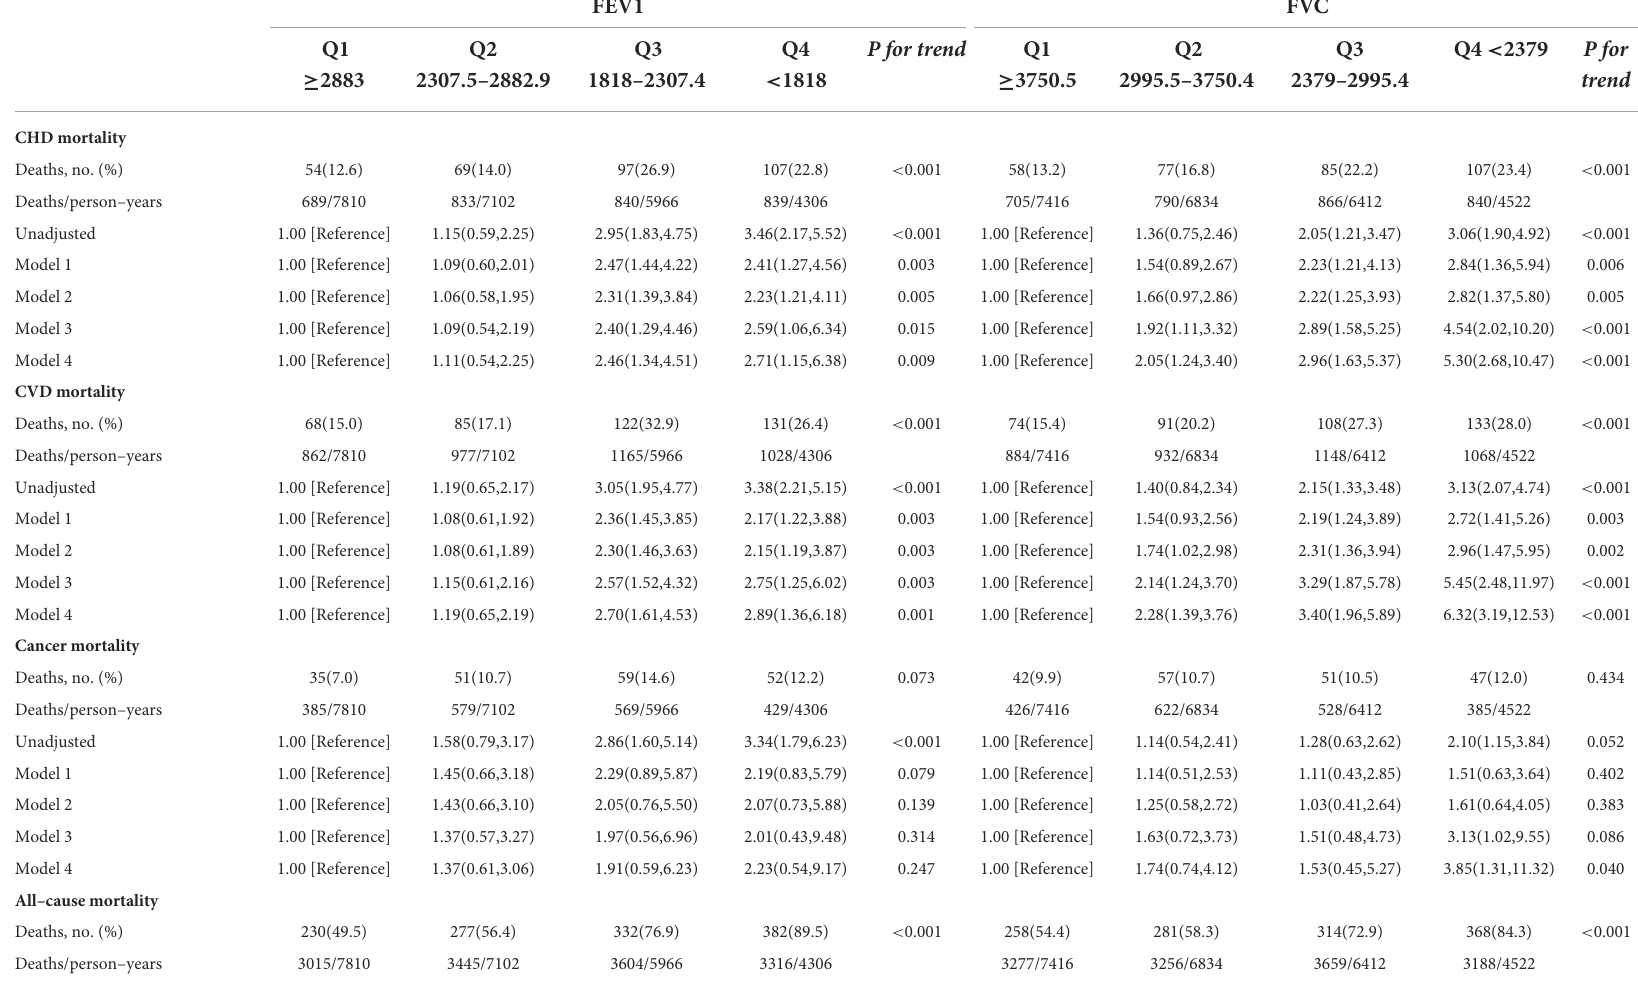
TABLE 2 Associations of FEV1 and FVC with coronary heart disease, cardiovascular, cancer and all–cause mortality in U.S. adults aged at least 20 years.